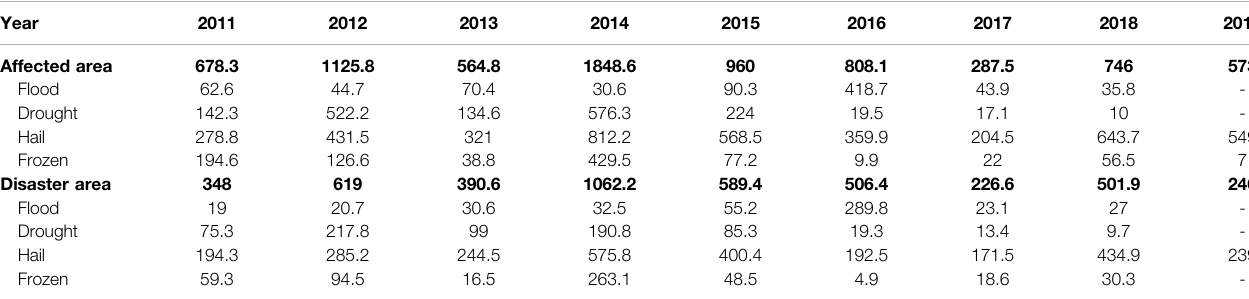
TABLE 2 | Statistical table of agricultural disaster-affected and disaster-affected areas in Xinjiang from 2011 to 2019 (unit: 1000